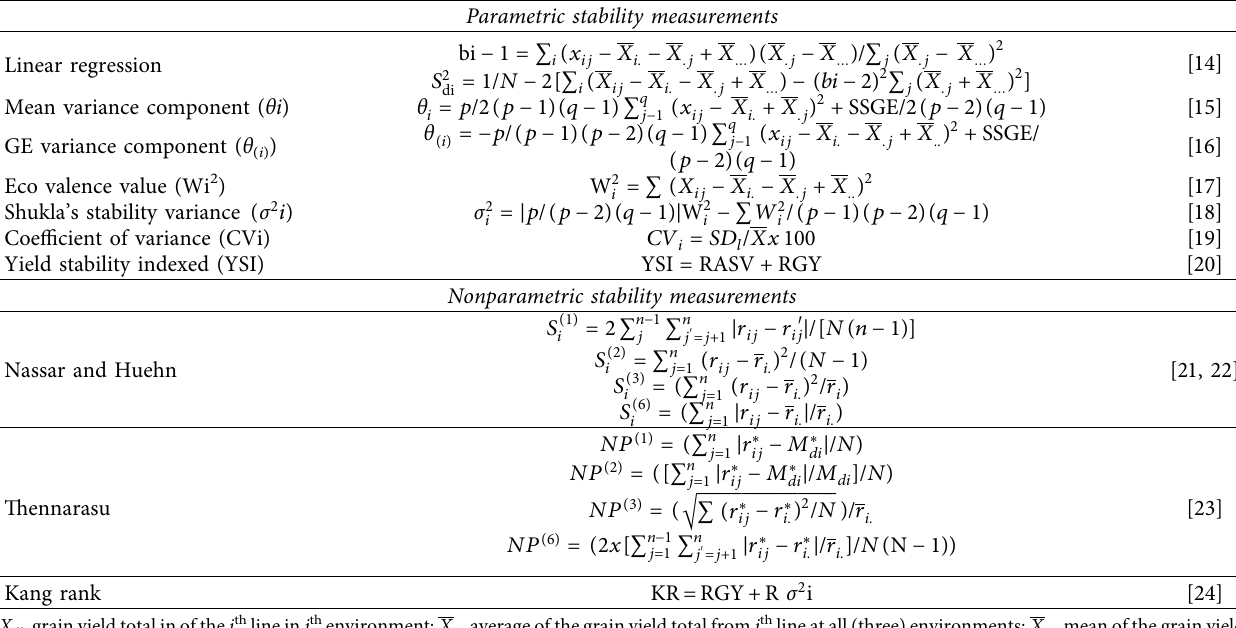
Table 2: Parametric and nonparametric stability measurements. Parametric stability